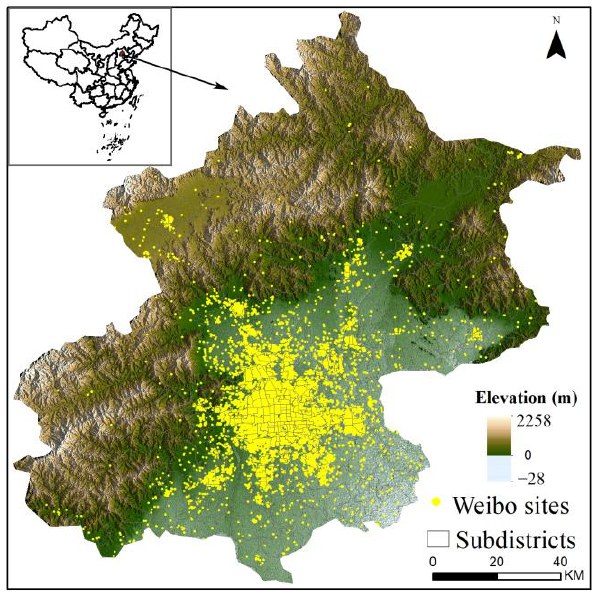
Figure 1. Study area in this